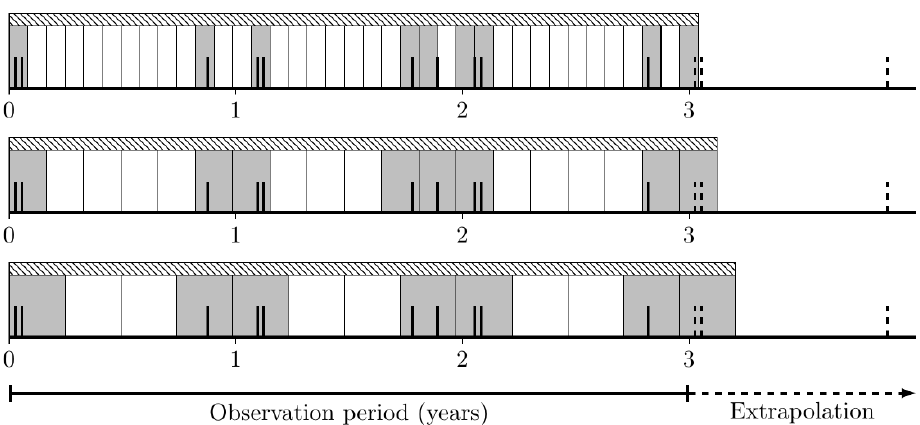
Figure 6. Method of different interval lengths, with events shown as bold black vertical bars. Gray intervals contain events and white intervals contain no events. The shaded bar shows the time scale analyzed.